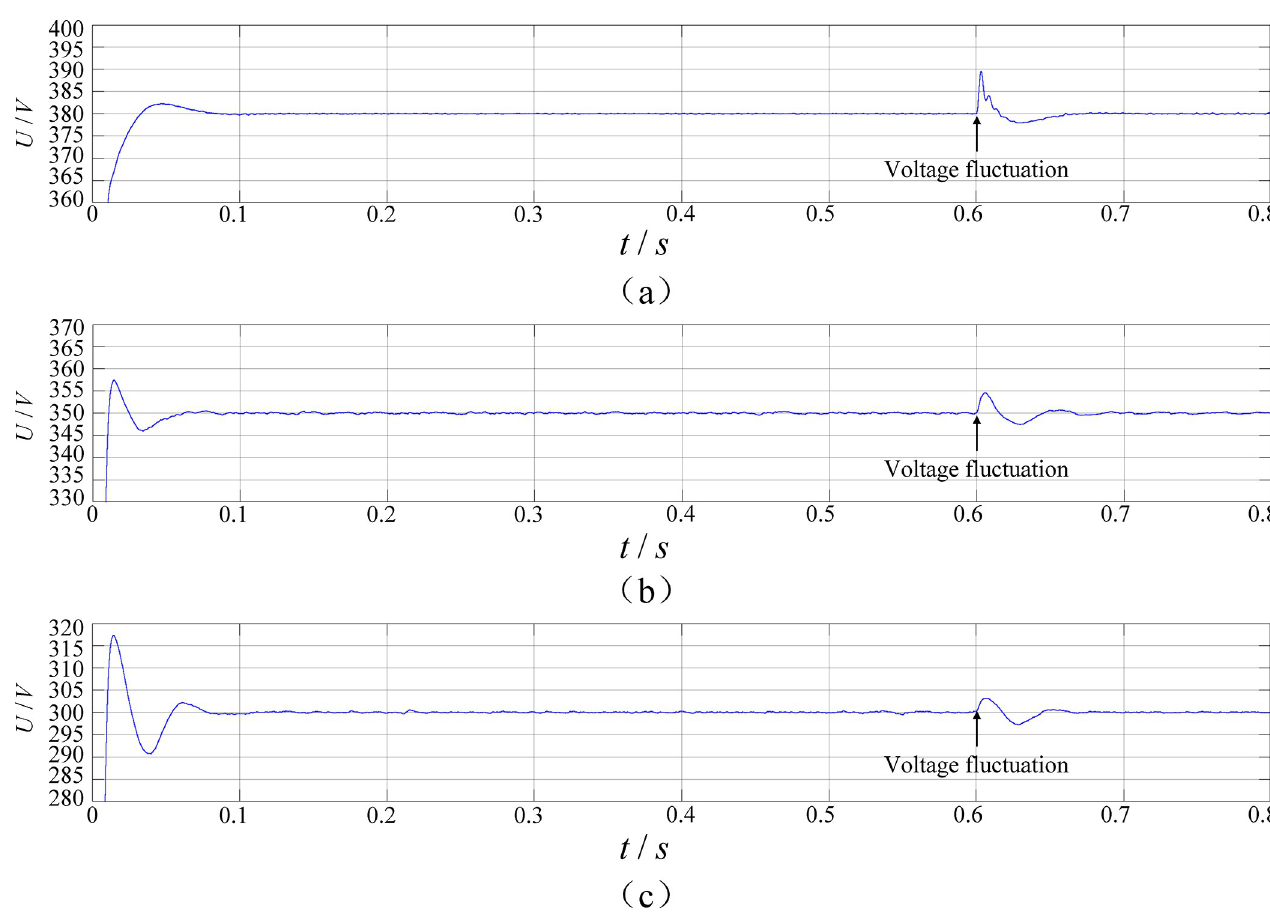
Fig 22. The output voltage waveform when the output voltage is 380V(a), 350V(b) and 300V(c).